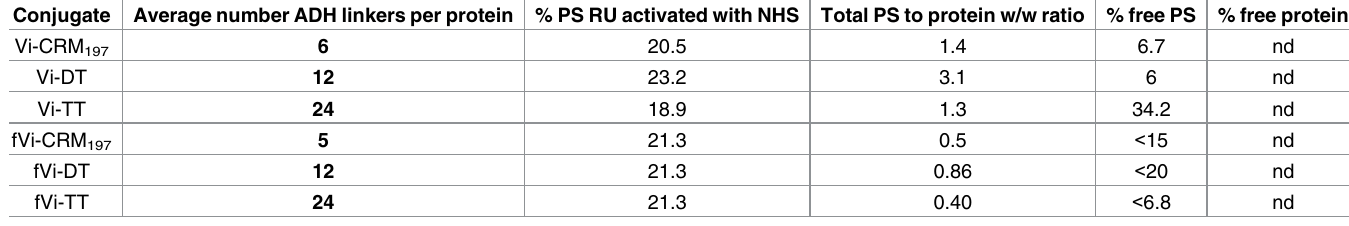
Table 1. Characterization of full-length and fragmented Vi conjugates by using different carrierproteins. Conjugate Average number ADH linkers per protein % PS RU activated with NHS Total PS to protein w/w ratio % free PS % free protein